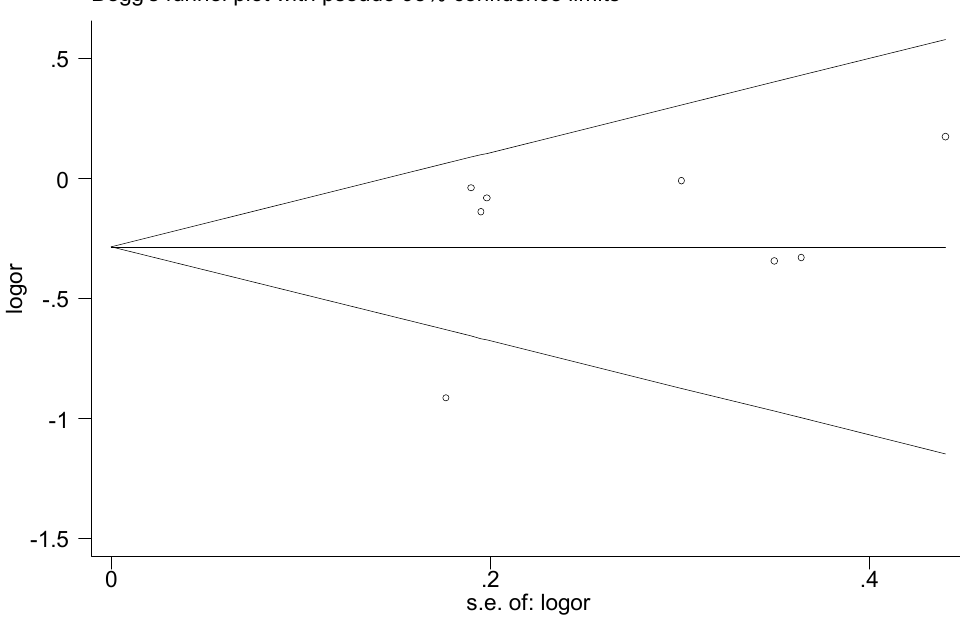
Figure 3. Funnel plots of total flavonoids intake and the risk of esophageal cancer.